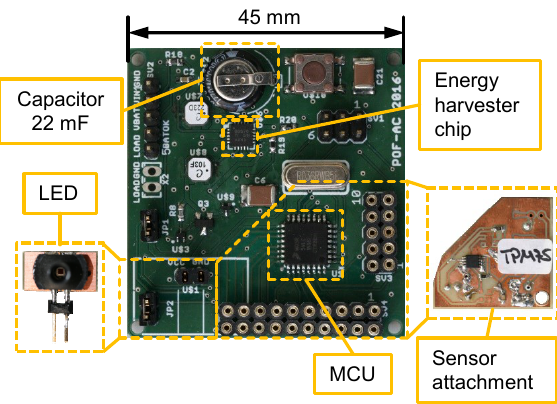
Figure 22. Sensor board hardware setup (TMP75): the sensor at- tachment is a prototype board containing the different sensors and is connected to the sensor node using the contacts around the